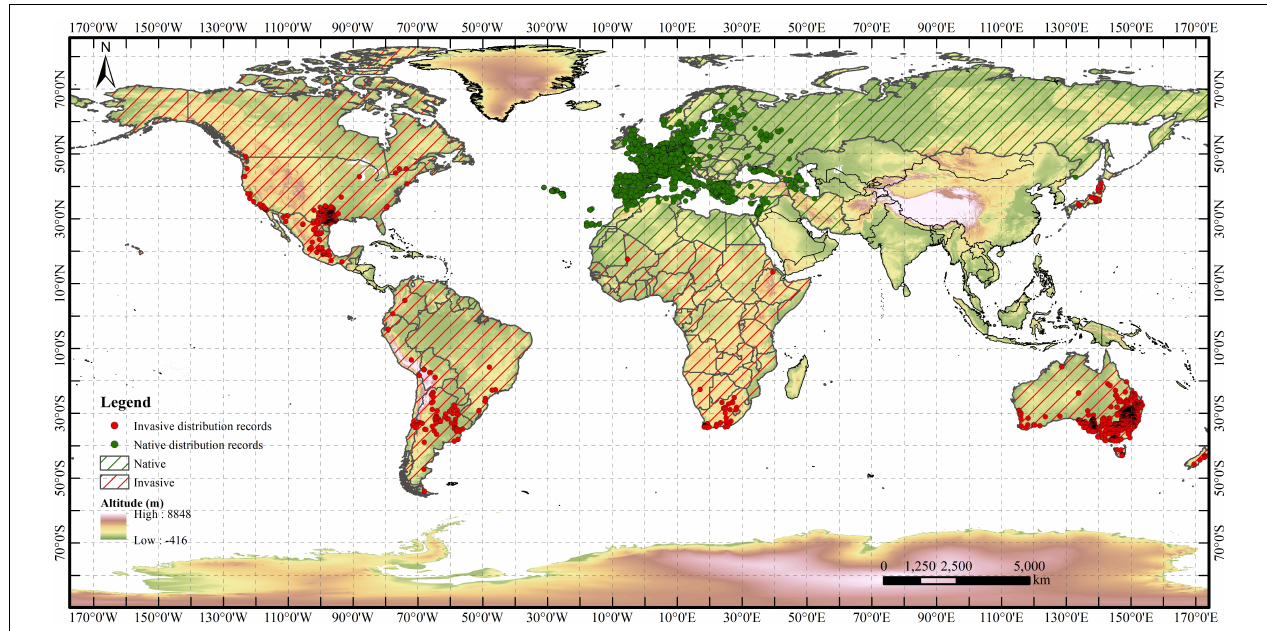
FIGURE 1 | World distribution records of Rapistrum rugosum. Red and green points indicate invasive and native distribution records,